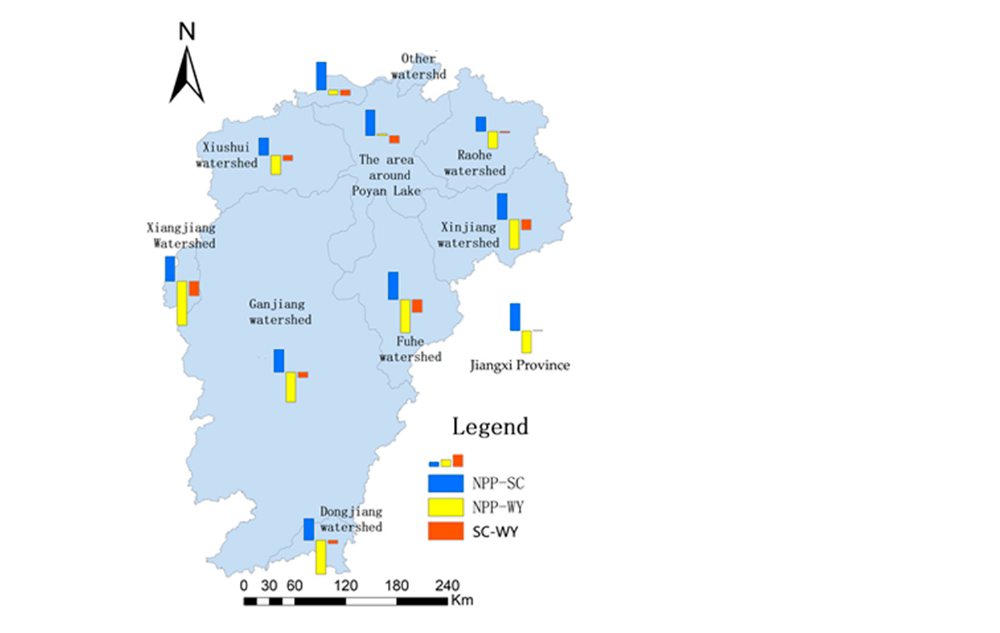
Figure 4. The trade-offs and synergies in ecosystem services in the whole province and river water- shed at grid scale.